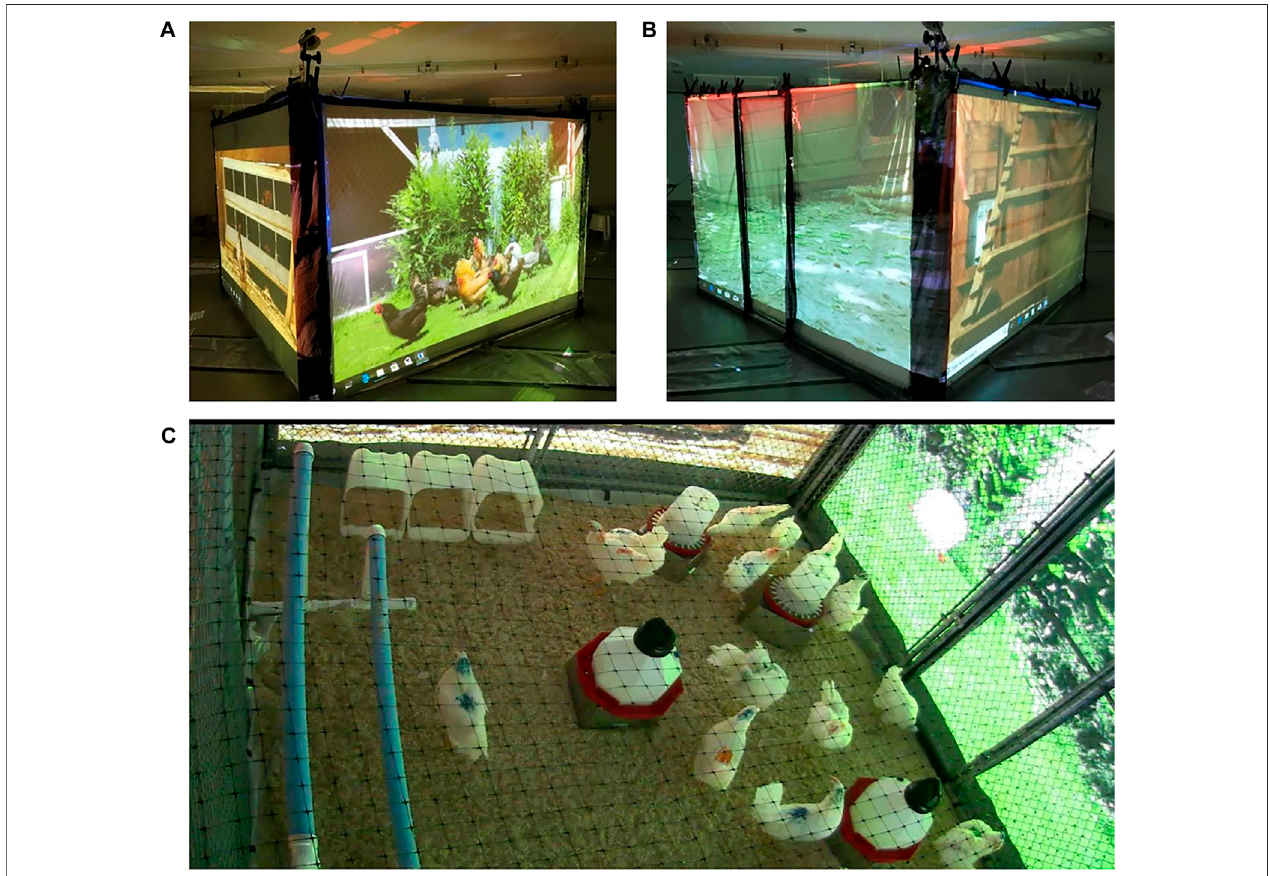
FIGURE 1 | Representative pictures of Virtual Reality (VR) outside (A,B) and inside (C) of the chickens ’ Pens. VR images were projected onto the vinyl projector screens placed against each pen wall in the VR group only.